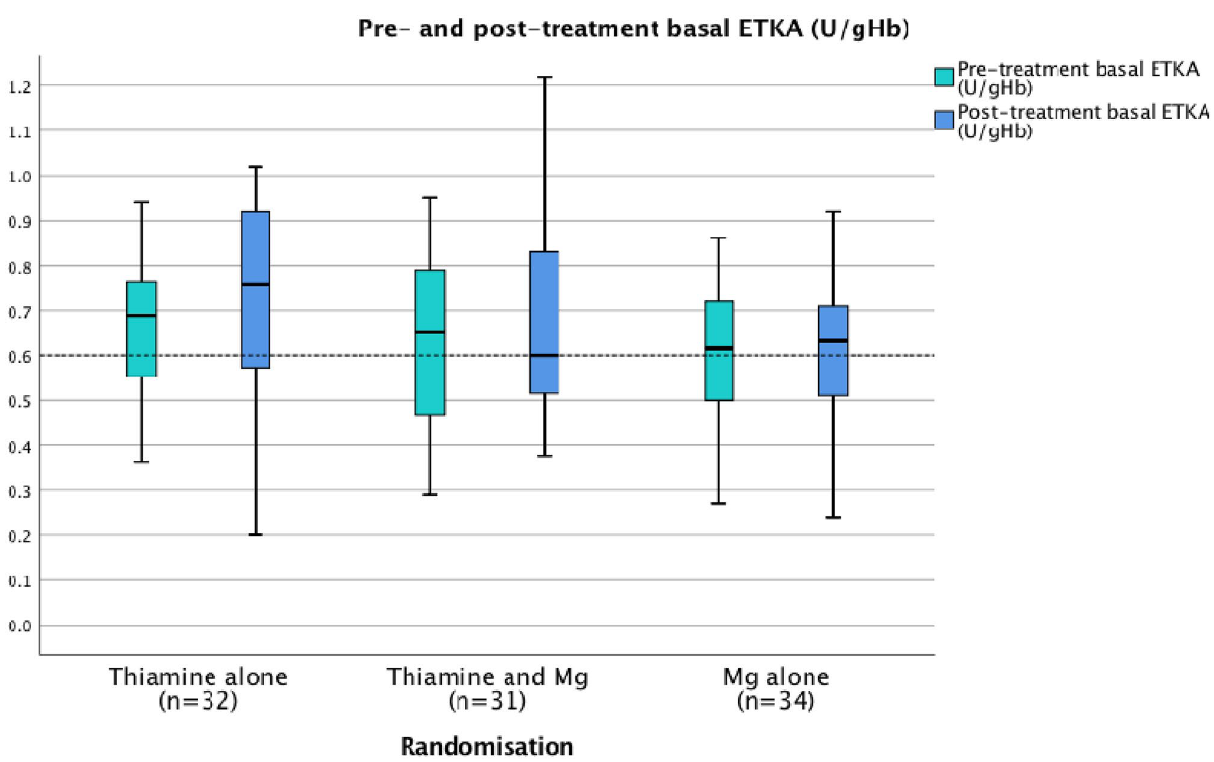
Figure 4. Pre- and post-treatment basal ETKA (n = 93).